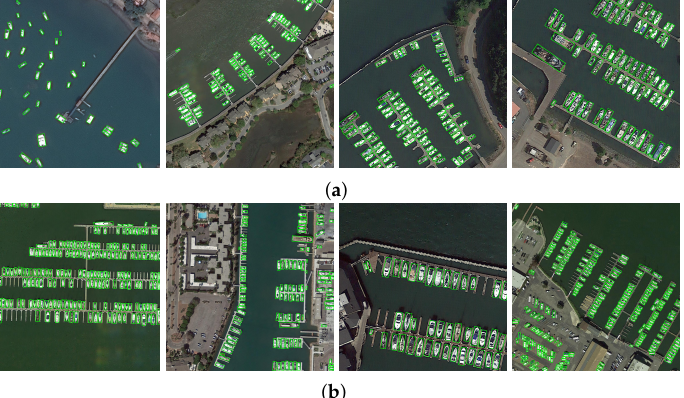
Figure 14. ( a , b ) Some of the detection results of a complex environment on DOTA-Ship. The green boxes indicate the correctly detected